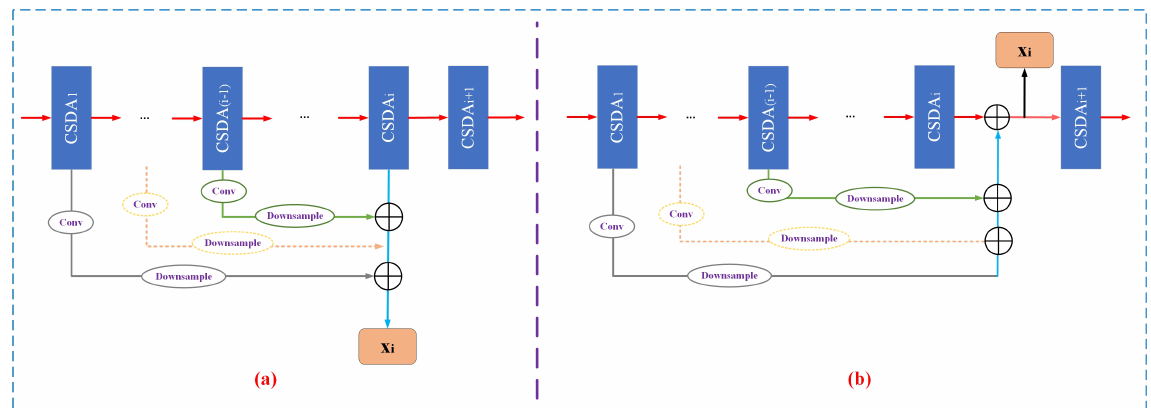
Figure 4. Densely connected feature pyramid extraction module. ( a ) Densely connected multi-scale features. ( b ) Resisual-based densely connected multi-scale